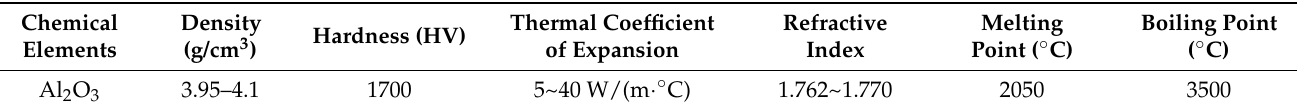
Table 1. Physical and chemical parameters of